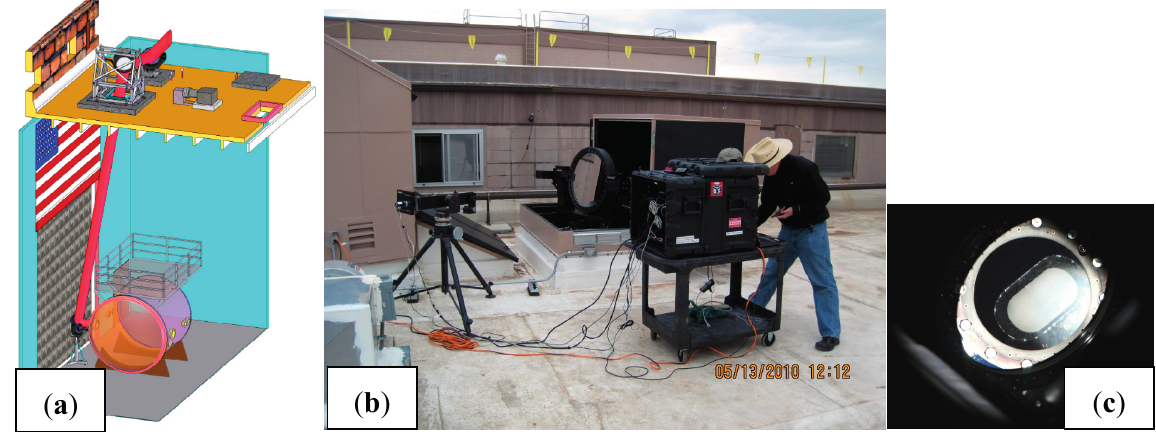
Figure 13. A cartoon of the heliostat facility, showing how sunlight is steered from the building roof into the thermal vacuum chamber ( a ); the rooftop set up of the heliostat during alignment and checkout ( b ); the OLI solar diffuser in its baffle while illuminated by the Sun from the heliostat ( c ).